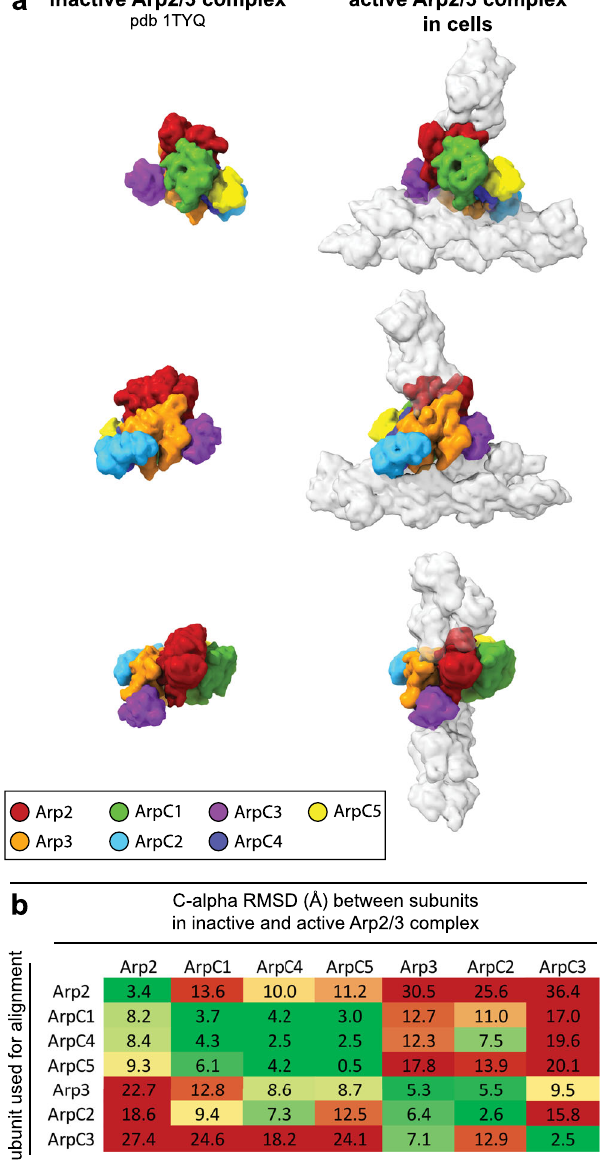
Fig. 2 Comparison of Arp2/3 complex in its inactive conformation and in the branch junction in cells. a Molecular models of the Arp2/3 complex in the inactive (derived from pdb 1TYQ) and the active conformation shown as density maps fi ltered to 9.5 Å resolution. The models are shown from three orientations, corresponding to the views in Fig. 1. Subunit colors are annotated in the fi gure with Arp2 being red, Arp3 orange, ArpC1 green, ArpC2 light blue, ArpC3 violet, ArpC4 dark blue, and ArpC5 yellow. Actin is shown in gray. b RMSD values (in Å) calculated between the inactive and active conformations of the individual Arp2/3 subunits (based on the models used in a ). Rows indicate which subunit was used for aligning the full models against each other, prior to measurements between individual subunits of the inactive and active Arp2/3 complexes (indicated in the columns). The RMSD analysis reveals that the structural transition upon complex activation is accommodated by two subcomplexes consisting of Arp2, ArpC1, ArpC4 and ArpC5 and Arp3, ArpC2 and ArpC3, respectively, that rotate against each other along an axis formed by the large helices of ArpC2 and ArpC4 (Supplementary Movie 4). RMSD variations between the same subunits in the inactive and active conformations derive from changes upon MD-based modeling of the x-ray crystal structure-derived model into the electron microscopy density map of the branch